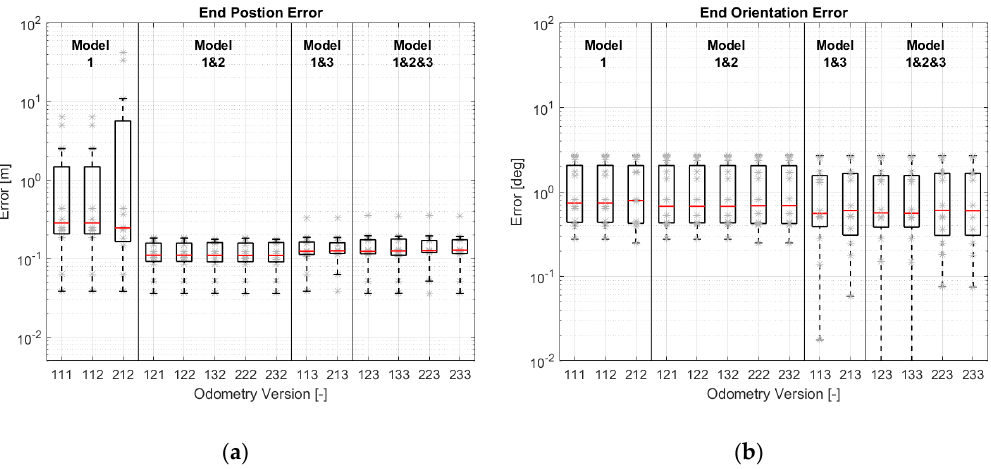
Figure 24. Real driving results of different odometry versions using a yaw rate sensor with a resolution of 0.1°/s: ( a ) End position errors; ( b ) End orientation errors.